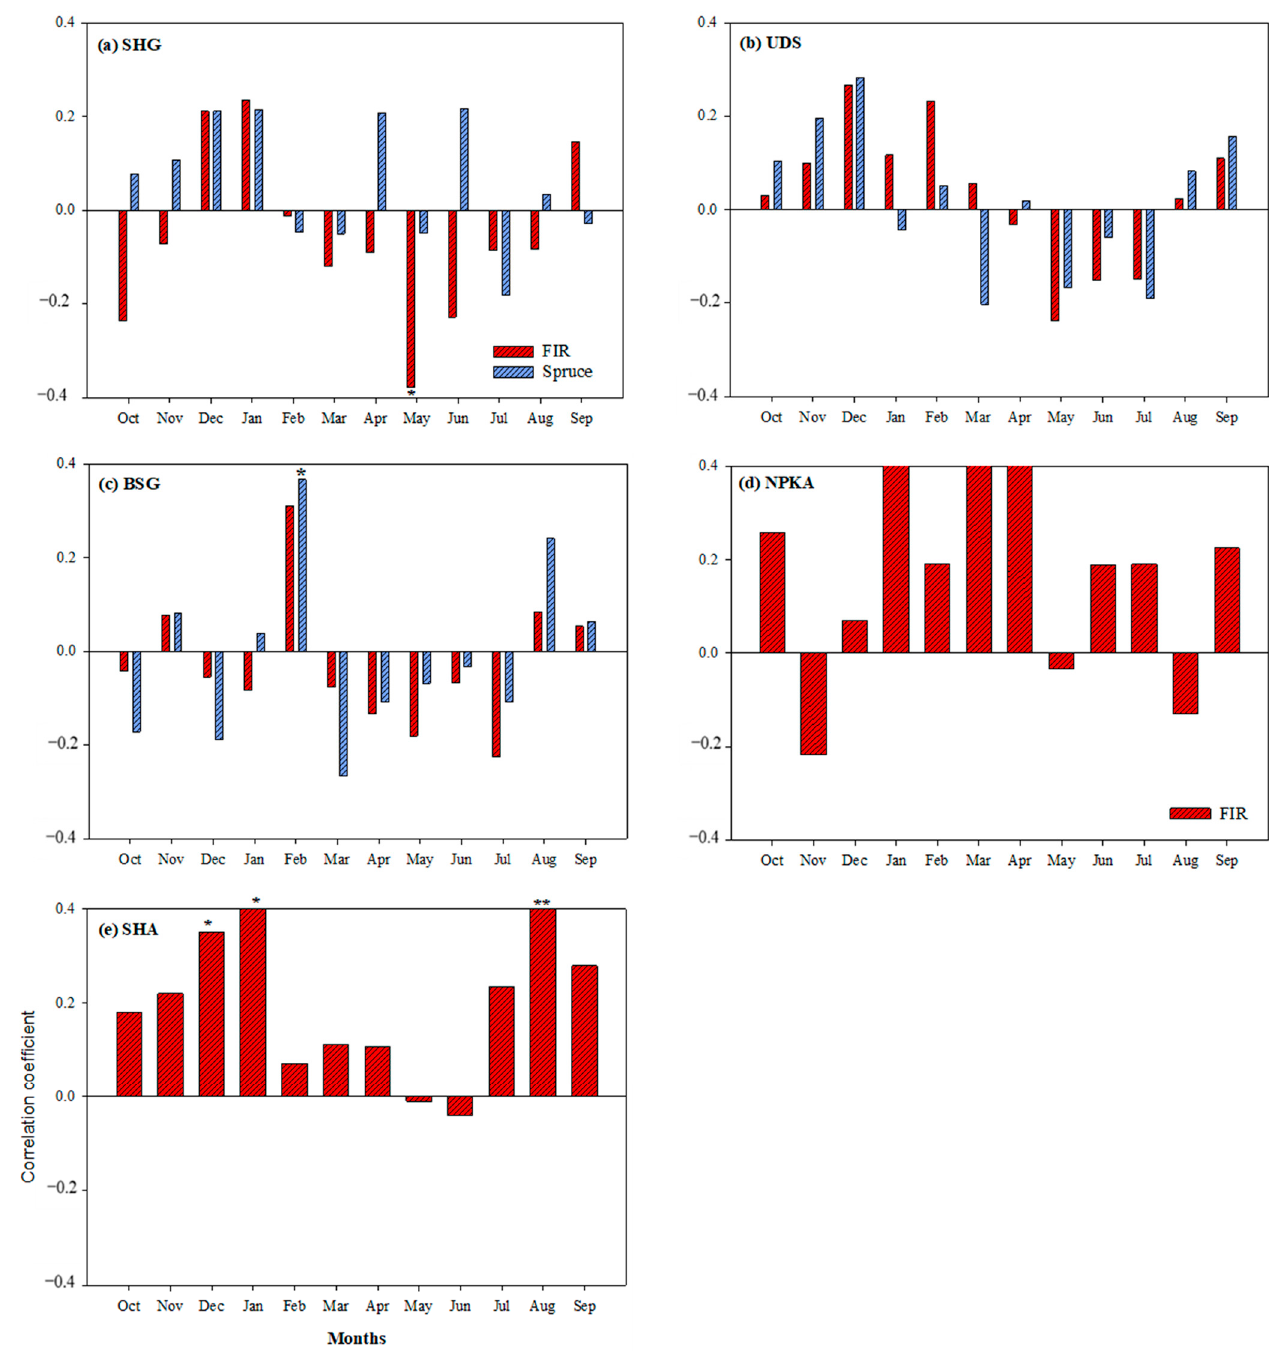
Figure 8. Response function analysis between the tree-ring-chronologies of spruce (blue bar) and fir (red bar) and mean annual temperature ( a – e ) during the period 1950–2018 at five sites (SHG, UDS, BSG. NPKA, and SHA) in Northern Pakistan. Stars indicate a significance level of p < 0.01.